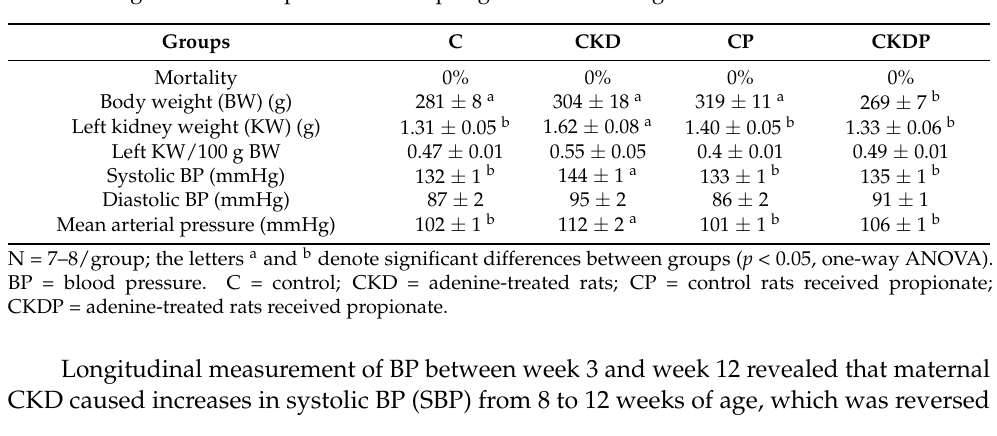
Table 2. Weights and blood pressure in offspring at 12 weeks of